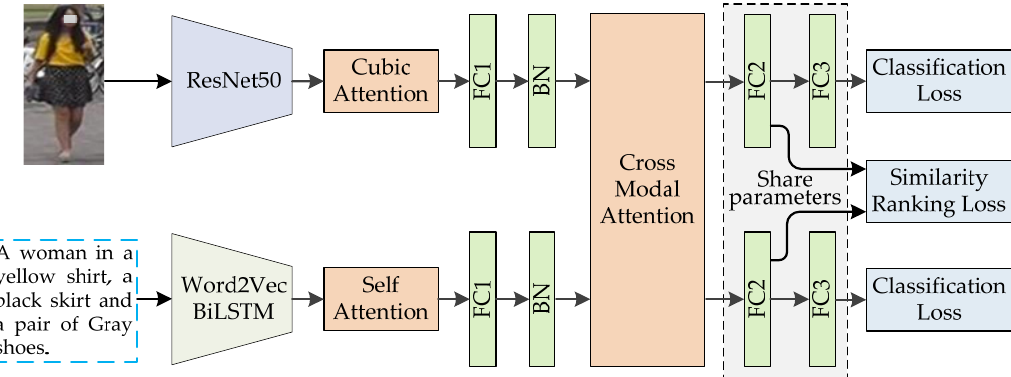
Figure 2. The architecture of the hybrid attention network for language-based person search. FC1, FC2, and FC3 denote full-connection layers, BN denotes batch-normalization layer.